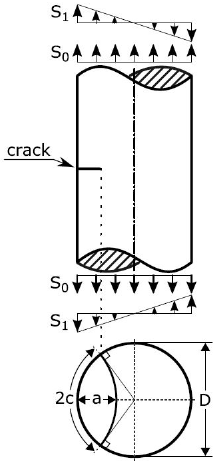
Figure 4. SC07-“semi-elliptical surface crack in solid cylinder”- crack case configuration [40]. Either a , the crack depth, or c , the circumferential crack length, can be used as the geometrical input parameter. S0 is uniform stress and S1 bending stress.